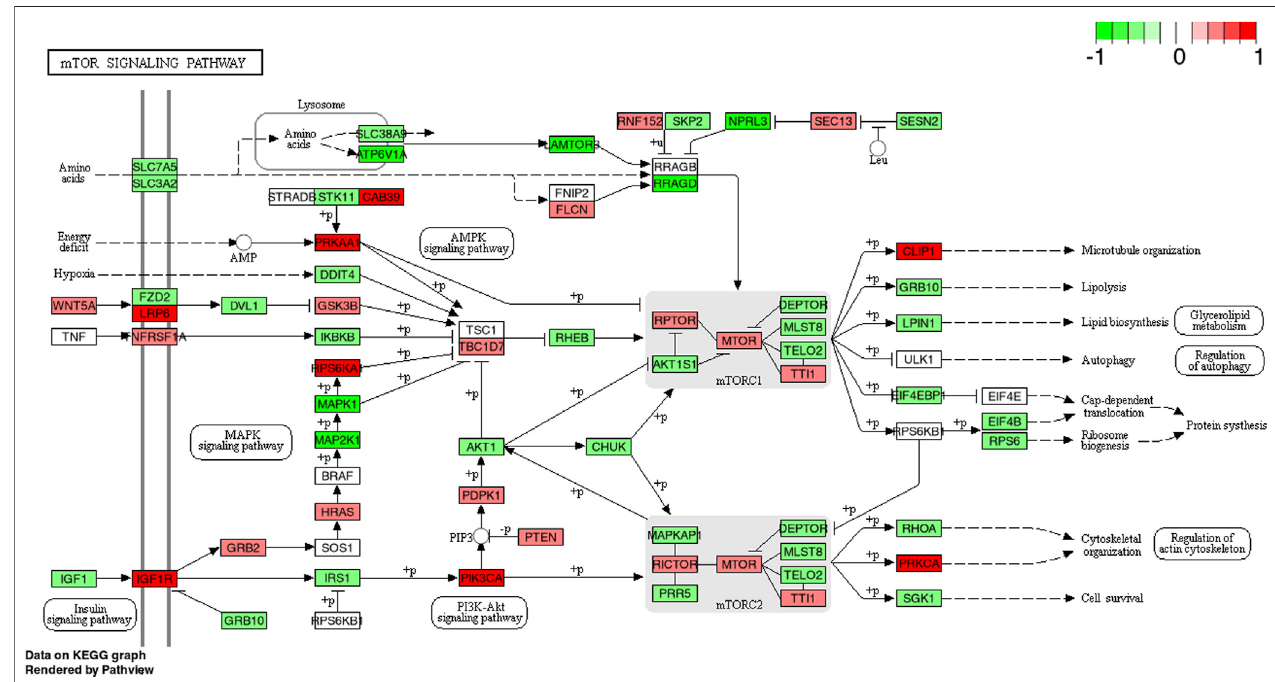
FIGURE5| KEGGpathway ofthemTORsignalingpathwaywithindividualgenesat4 hcomparingCP(collagenpeptides)andPLA(placebo).Colorlabelindicates genes that are up (red) or down (green) regulated compared to PLA. Dark coloring = p -value equal or below 0.05, light coloring = p -value higher than 0.05.